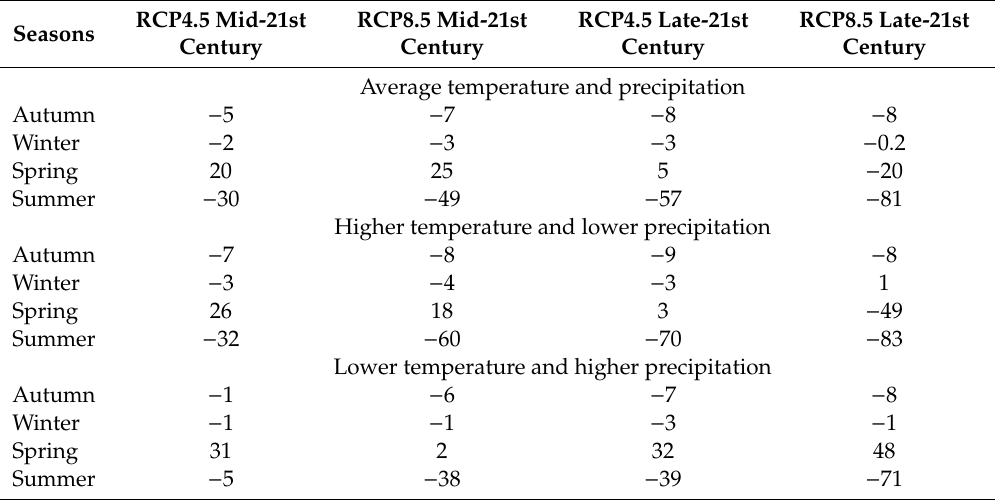
Figure 10. Projected river flows during the late 21st century (2089–2095) under ( a ) RCP4.5 and ( b ) RCP8.5, for the average, lower, and higher temperature and precipitation scenarios and the resulting projected SCAs. Table 6. Projected seasonal flows variations in m 3 / sec during the mid- and late 21st century under RCP4.5 and RCP8.5, for average, lower, and higher temperature and precipitation scenarios.